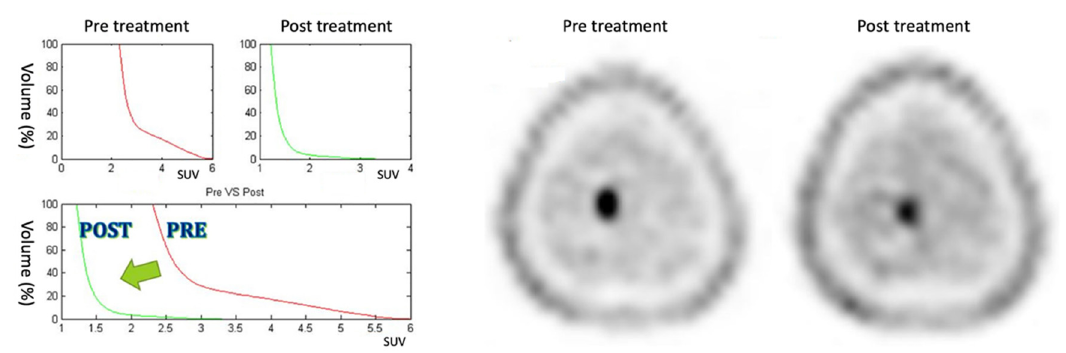
Figure 6. On the left: CSH pretreatment (top left); CSH post-treatment (top right); comparison between pre- and post- treatment (bottom) in positive response case: ∆ AUC = − 59.05%. On the right: PET images of pre- and post-treatment. (For interpretation of the references in colour in this figure legend, the reader is referred to the web version of this article.)